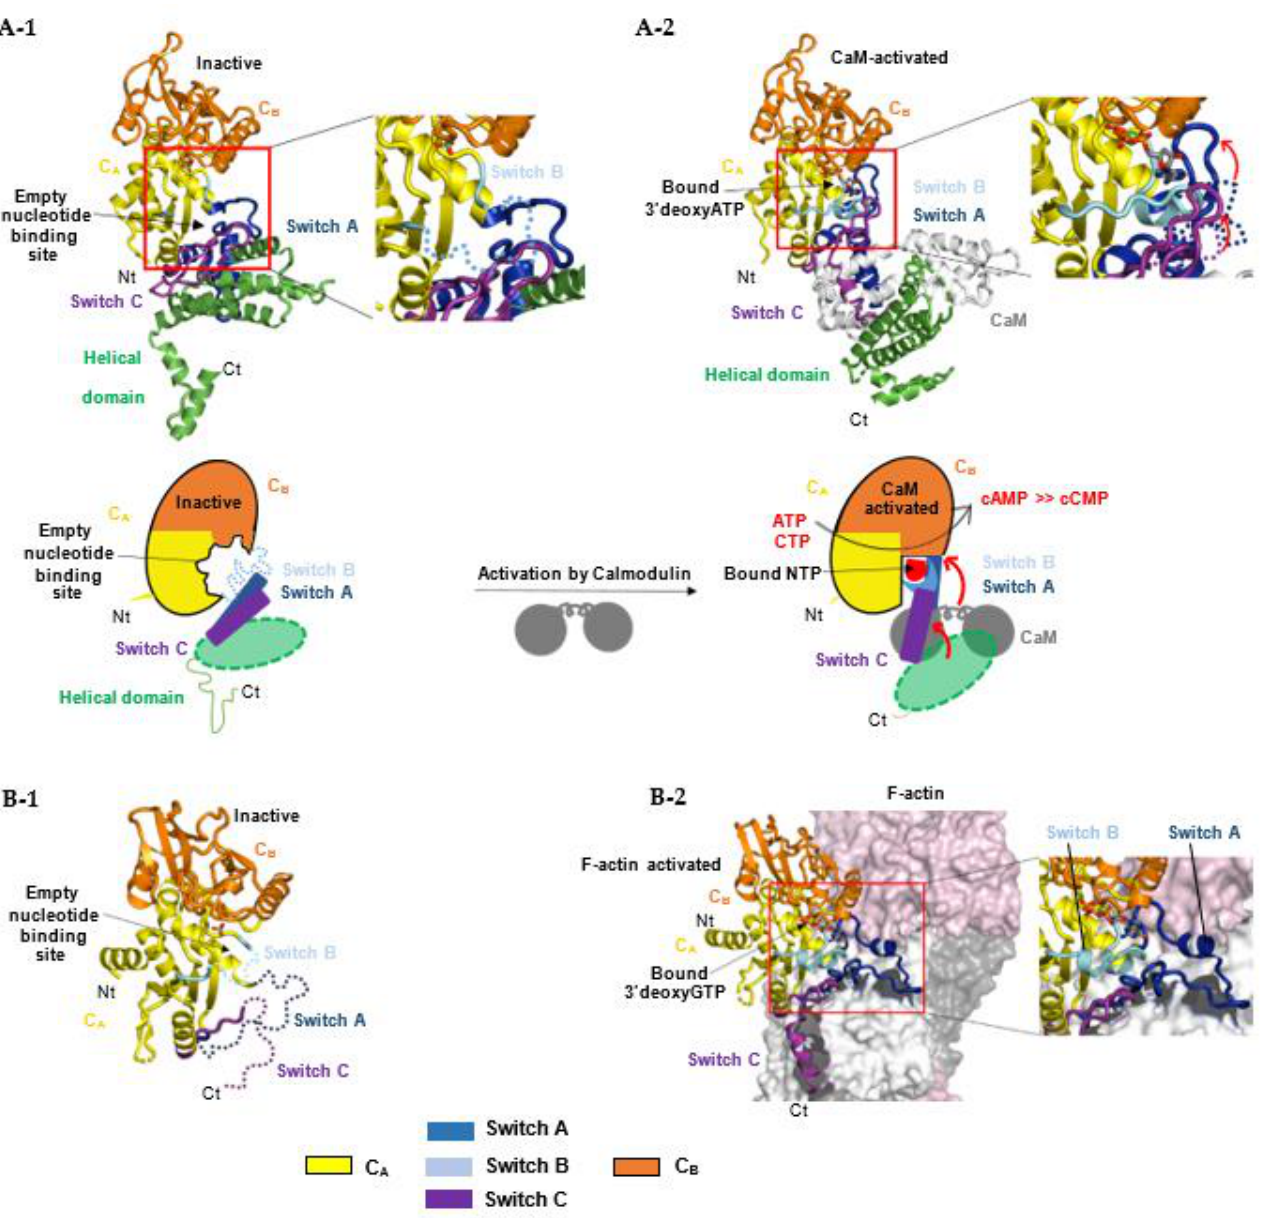
different structural snapshots of Vn -ExoY interaction and activation mechanism by G-actin- ATP or -ADP at resolutions between 2 and 1.7 Å [101]. All these structures show that F- or G-actin-activated ExoY homologs use the same contacting regions with actin subunits as EF or CyaA with CaM, i.e., their switches A and C (Figure 7B-2), called sensor and anchor regions in [39], respectively. Molecular dynamics simulations on the structure of Pa -ExoY bound or unbound to F-actin suggest that its two switch regions, A and C, are highly flexible regions when the F-actin-activated structure of Pa -ExoY is unbound, and that changes at switch A and C are transmitted to the nucleotide-binding pocket [39].